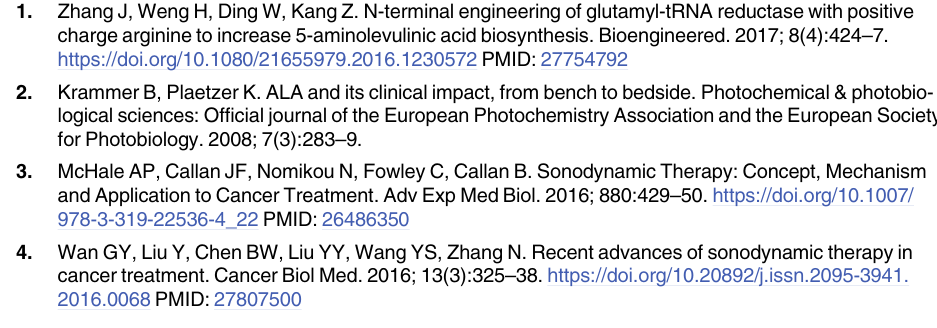
(B) Cardiolipin oxidation was determined by using fluorospectrophotometer with the staining of NAO. (C) mitochondrial membrane potential was assessed by using fluorospectrophot- ometer with the staining of jc-1. (cid:3)(cid:3) P < 0.01 compared to baseline, (cid:3)(cid:3)(cid:3) P < 0.001 compared to baseline. S3 Fig. Effects of PK11195 on ALA-PpIX accumulation, and ROS generation and cell apo- ptosis by SDT in isolated murine peritoneal macrophages. (A) Peritoneal macrophages were isolated from C57BL/6 mice and confirmed by immunofluorescent staining with CD68 antibodies. Scale bar represents 0.1 mm. (B) Fluorescence intensity of PpIX in the indicated groups detected by a fluorescence microplate reader. (C) Intracellular ROS generation in the indicated groups detected by fluorospectrophotometer with the staining of fluorescent probe DCFH-DA. (D) Quantifications of early apoptosis rate in the indicated groups measured by flow cytometry with double staining of Annexin V and PI. (cid:3)(cid:3)(cid:3) P < 0.001 compared to control group. ## P < 0.01, ### P < 0.001 compared to SDT